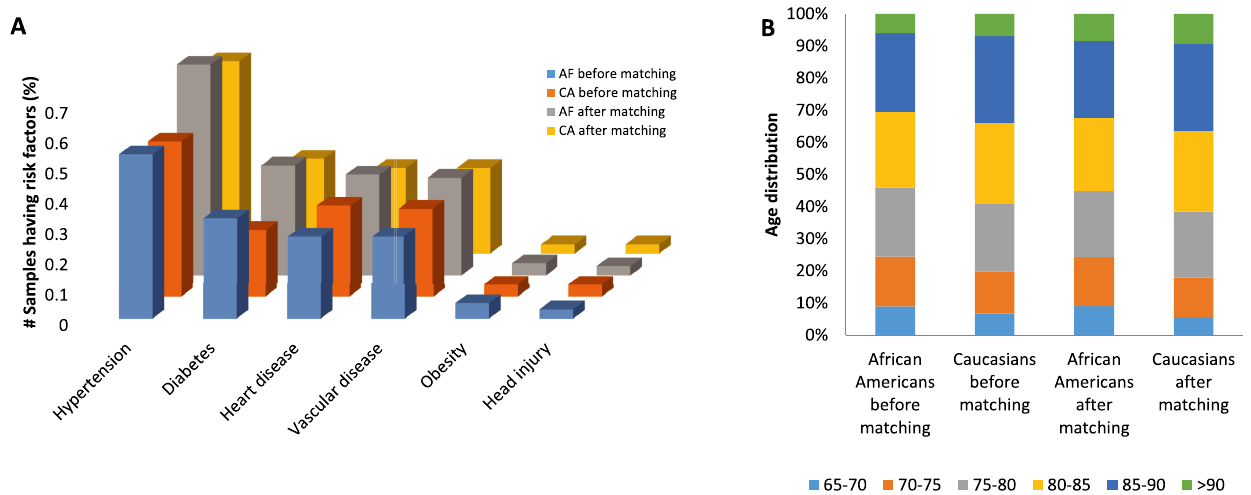
Fig 2. Subject’s age and known risk factor distributions. (a) Onset age distribution of ADRD patients after matching Caucasians to African Americans. The onset age of (original) Caucasians tends to be older than that of African Americans. The matched Caucasian follows a similar distribution. (b) Distribution of known risk factors after matching. The matched Caucasian follows a similar distribution with African Americans in terms of the confounding risk factors. Ca = Caucasians, Paired Ca = Caucasians that are matched to African Americans. AF = African